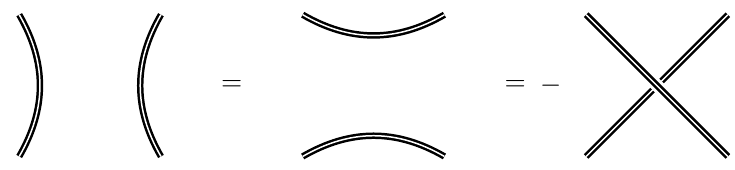
Figure 4 . The (cid:5) lines have fermionic statistics and thus extra signs may occur as the worldlines are